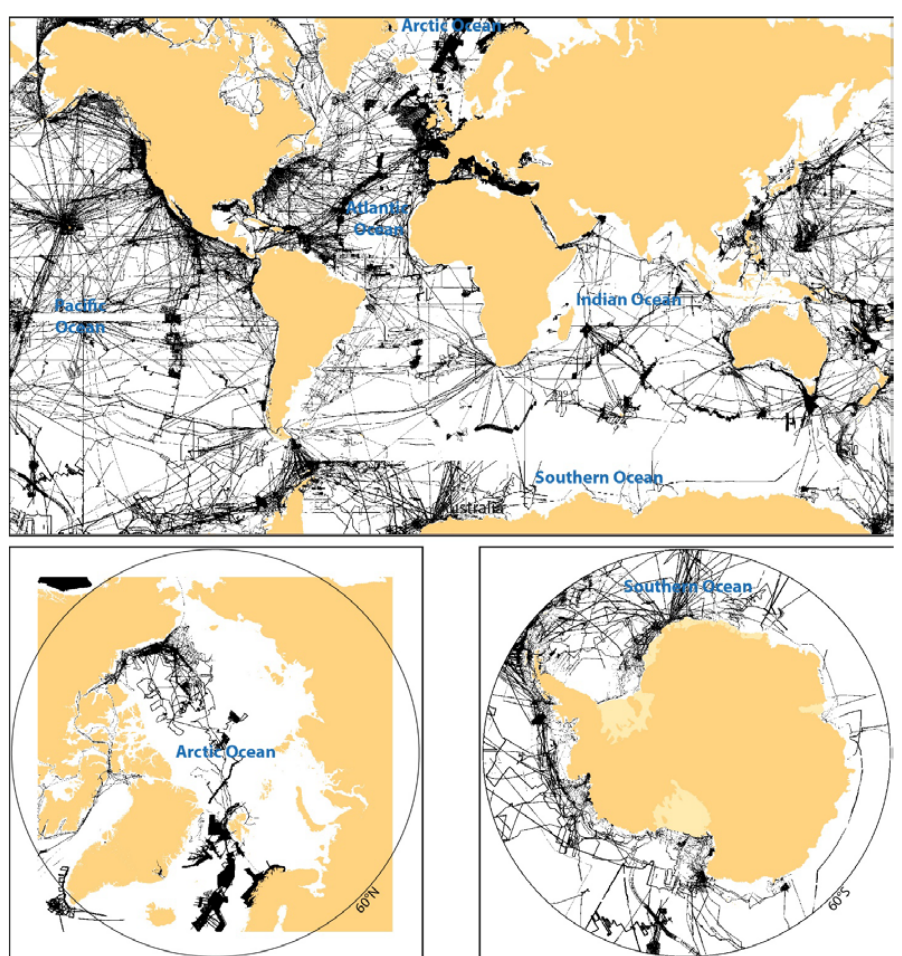
Figure 5. Tracklines of multibeam bathymetry included in the GEBCO-2014 grid. Map is from the Nippon Foundation—GEBCO—Roadmap for Future Ocean Floor Mapping [20].